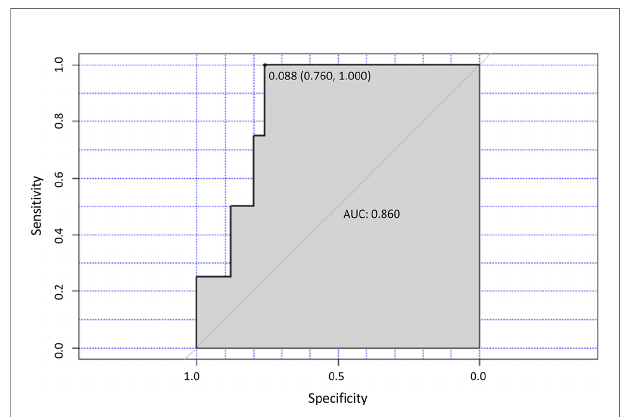
FIGURE 6 | Th2/TH1 ratio and response to treatment. ROC curve analysis for the optimal cut-off point of the Th2/Th1 ratio at M8 of ibrutinib treatment. The area under the curve (AUC) value for the Th2/Th1 ratio was 0.860.